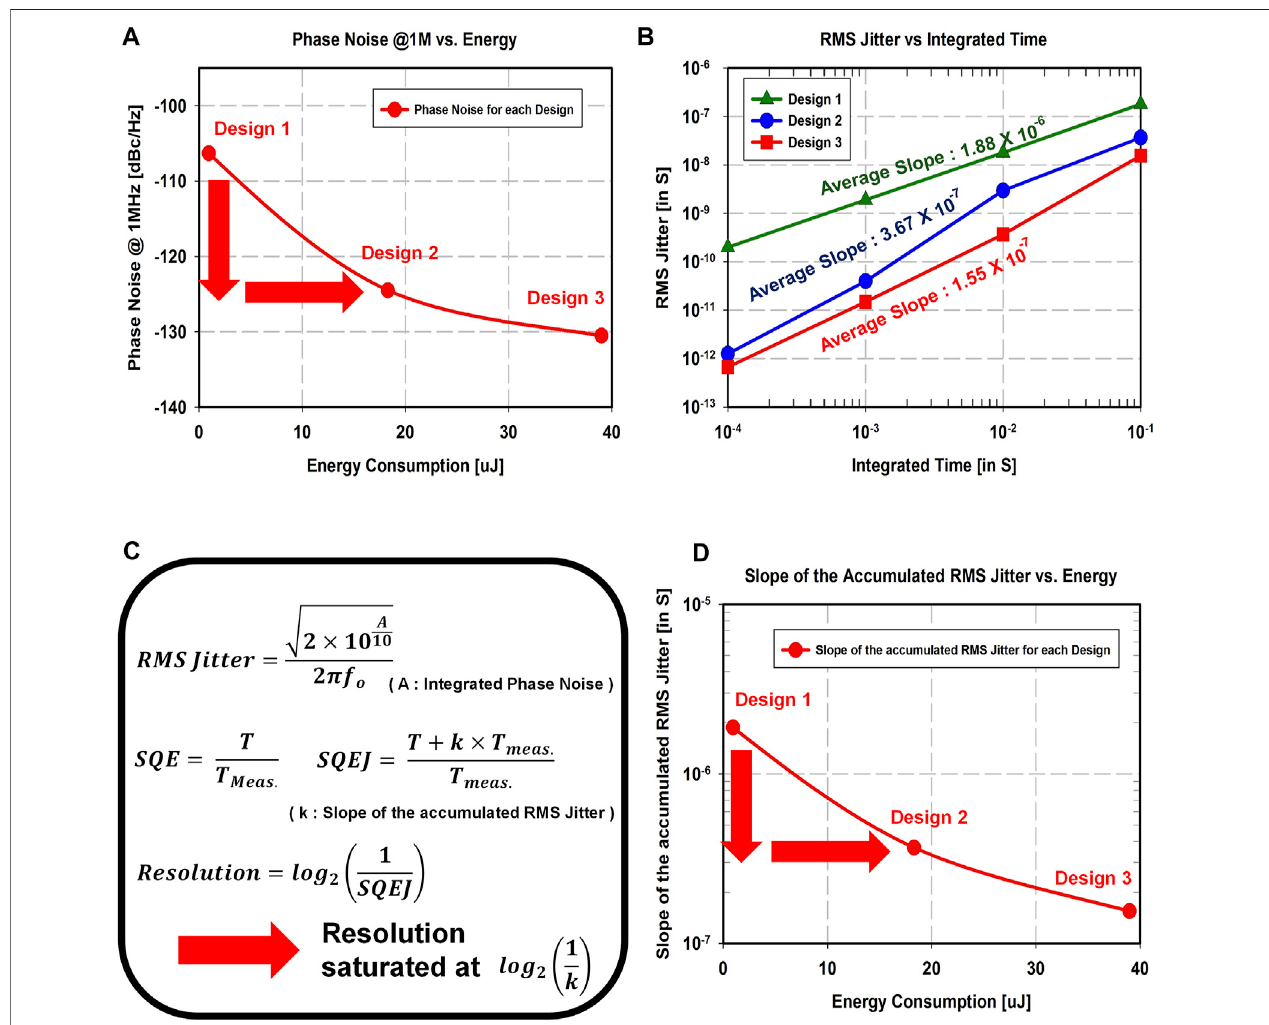
FIGURE 10 | Simulation results for the three time-based RDCs: (A) phase noise vs. energy consumption, (B) the accumulated rms jitter vs. time of measurement, (C) equations, and (D) the slope of the accumulated rms jitter vs. energy consumption.